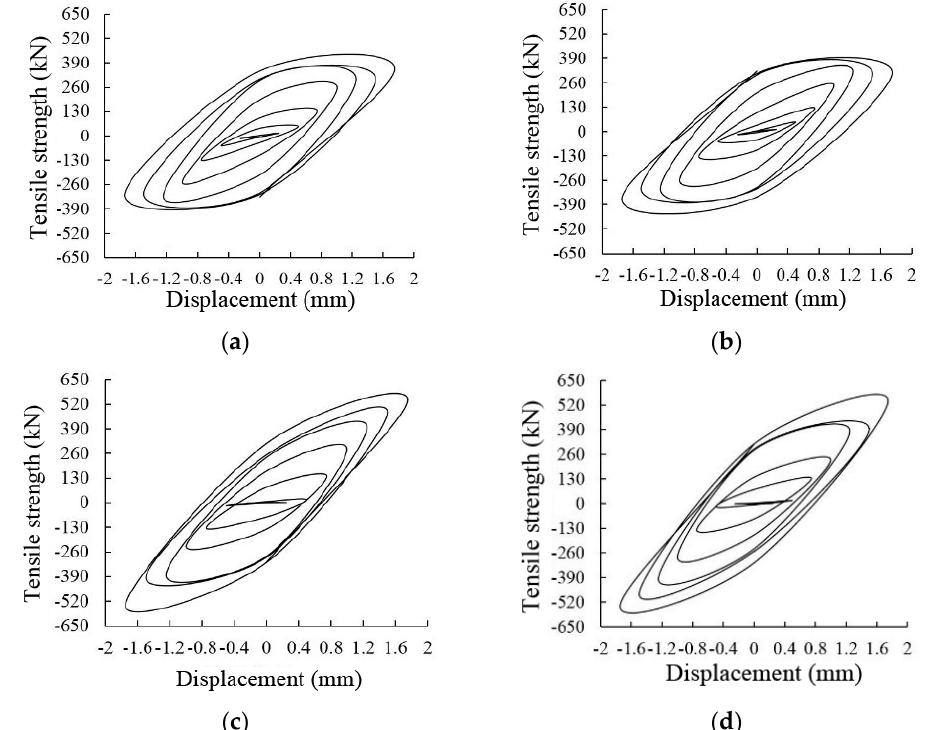
Figure 15. Displacement-strain curves for the steel angles: ( a ) EDA-UL; ( b ) EDA-UR; ( c ) EDA-DL; ( d ) EDA-DR. Table 3. Energy dissipation capacities of the steel angles.